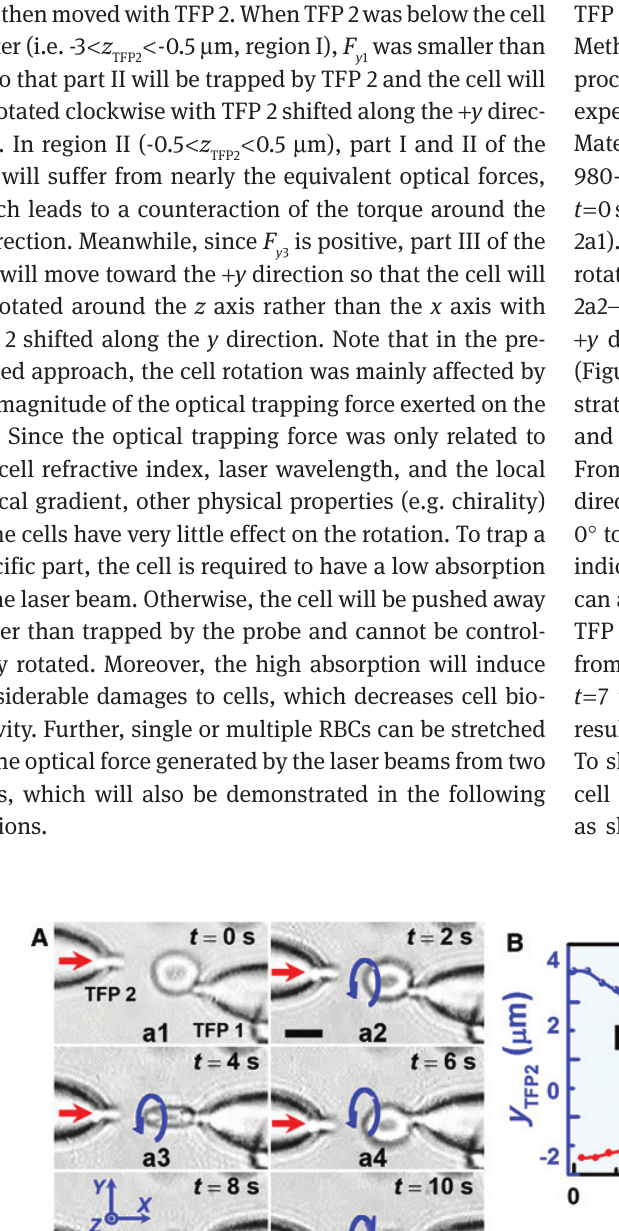
and ω in the rotation TFP2 RBC